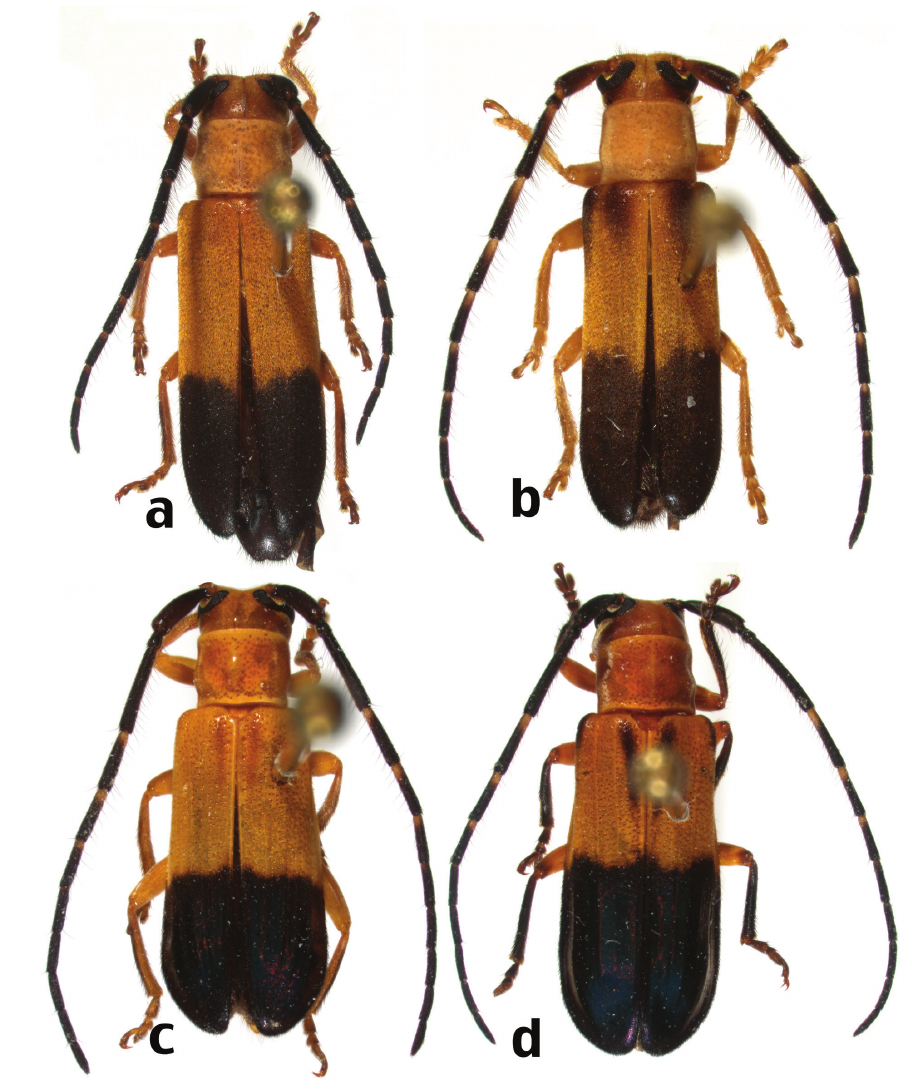
Figure 7. Dorsal habitus of Calocosmus species: a C. chevrolati Fisher (morphotype 1) b C. chevrolati Fisher (morphotype 2) c C. hispaniolae Fisher (morphotype 1) d C. hispaniolae Fisher (morphotype